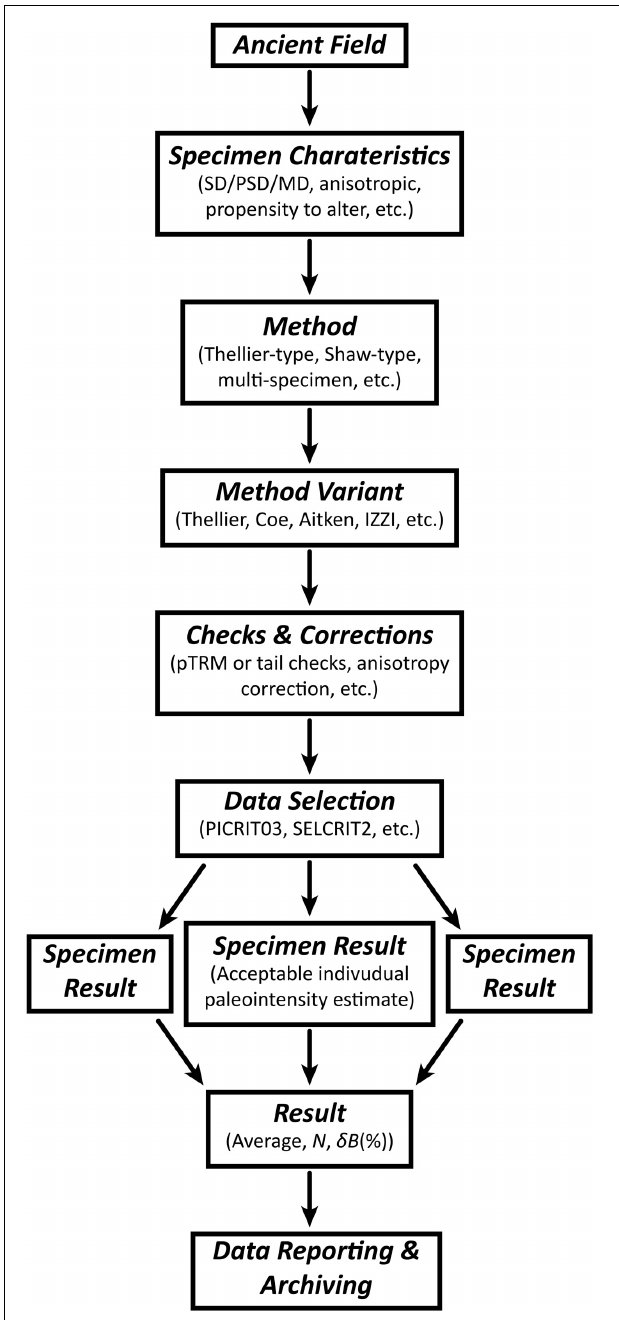
FIGURE 1 | Simplified flow chart of the basic stages of obtaining a paleointensity result. This process can be viewed as a series of natural, technical, and data analysis filters that successively modify the signal of the Ancient Field and ultimately produce the final Result .